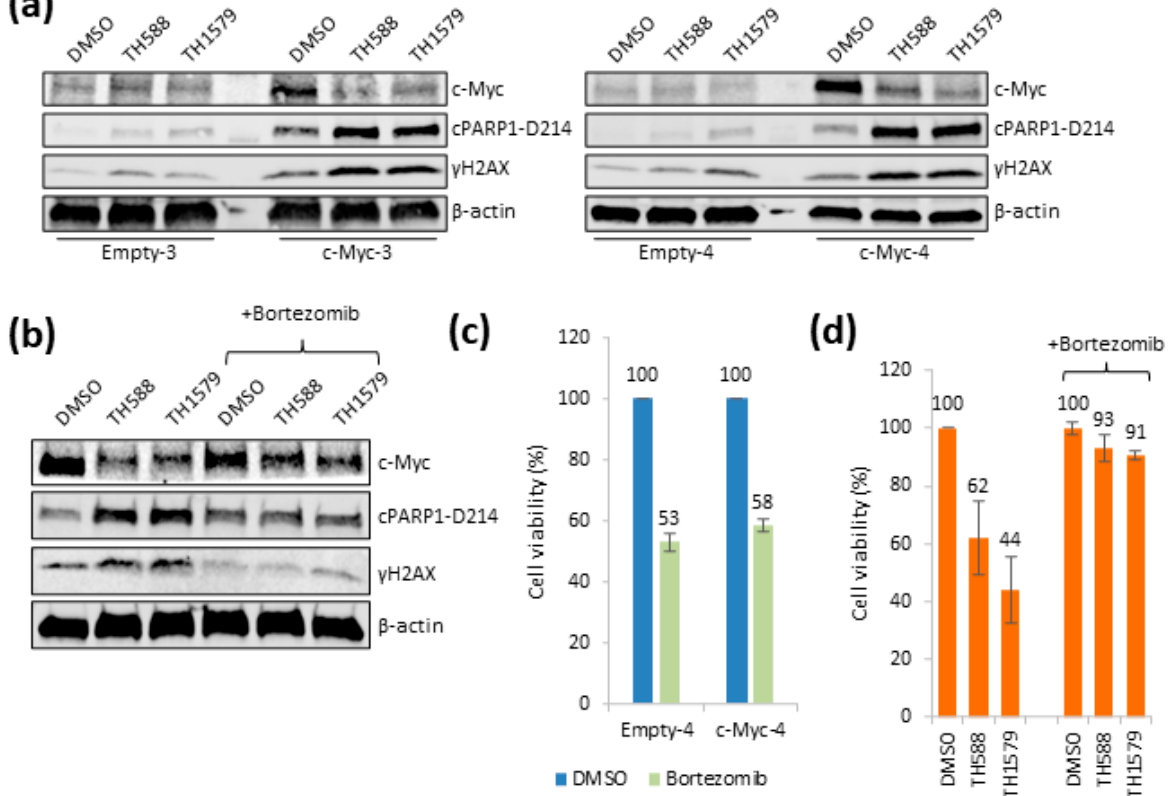
Figure 5. TH588 and TH1579 trigger cell death by degradation of c-Myc protein. ( a ) Empty-3/c-Myc-3 or Empty-4/c-Myc-4 were treated with 5 µM TH588 or 0.5 µM TH1579 for 24 h. Following cell lysis, the indicated proteins were blotted. ( b ) c-Myc-4 cells were treated with 5 µM TH588 or 0.5 µM TH1579 for 24 h ± co-addition of bortezomib (10 nM). The indicated proteins were blotted. ( c , d ) c-Myc-4 cells were seeded and following 24 h, the cells were treated with 5 µM TH588 or 0.5 µM TH1579 for 24 h ± co-addition of bortezomib (10 nM). Then, 10 µg/mL resazurin was added for 4 h and viability was determined (values are normalized to internal DMSO control), n = 2 ± S.E.M.